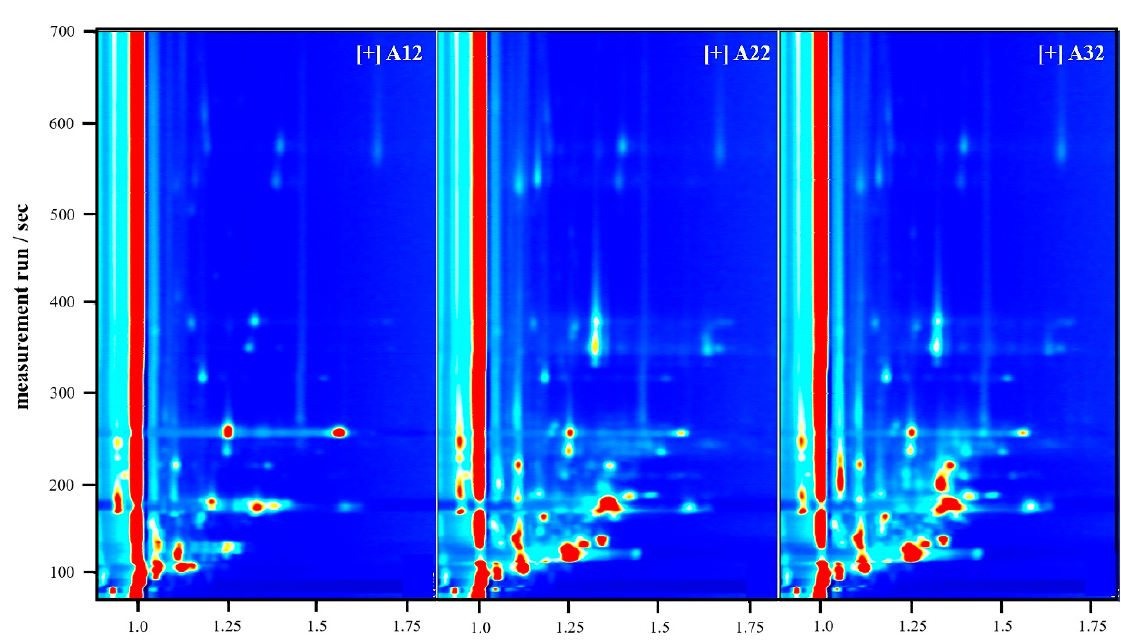
Figure 4. 2D topographic plots of volatile compounds in tuna